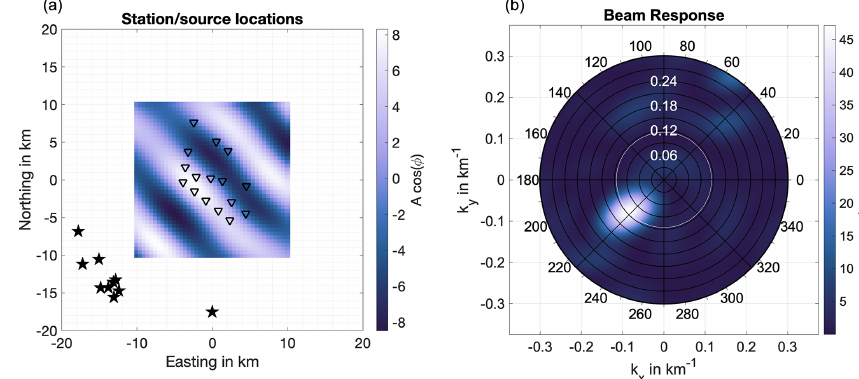
Figure 4. (a) Example source distribution (red stars) around the Los Humeros stations (black triangles) with the real part of the resulting synthetic wavefield shown in the background. The wavefield is computed in the frequency domain for one frequency; thus there is no time dependency. (b) Beam response obtained for synthetic data shown in (a) . The white circle marks the true horizontal wavenumber k = f/v = 0 . 115km − 1 .